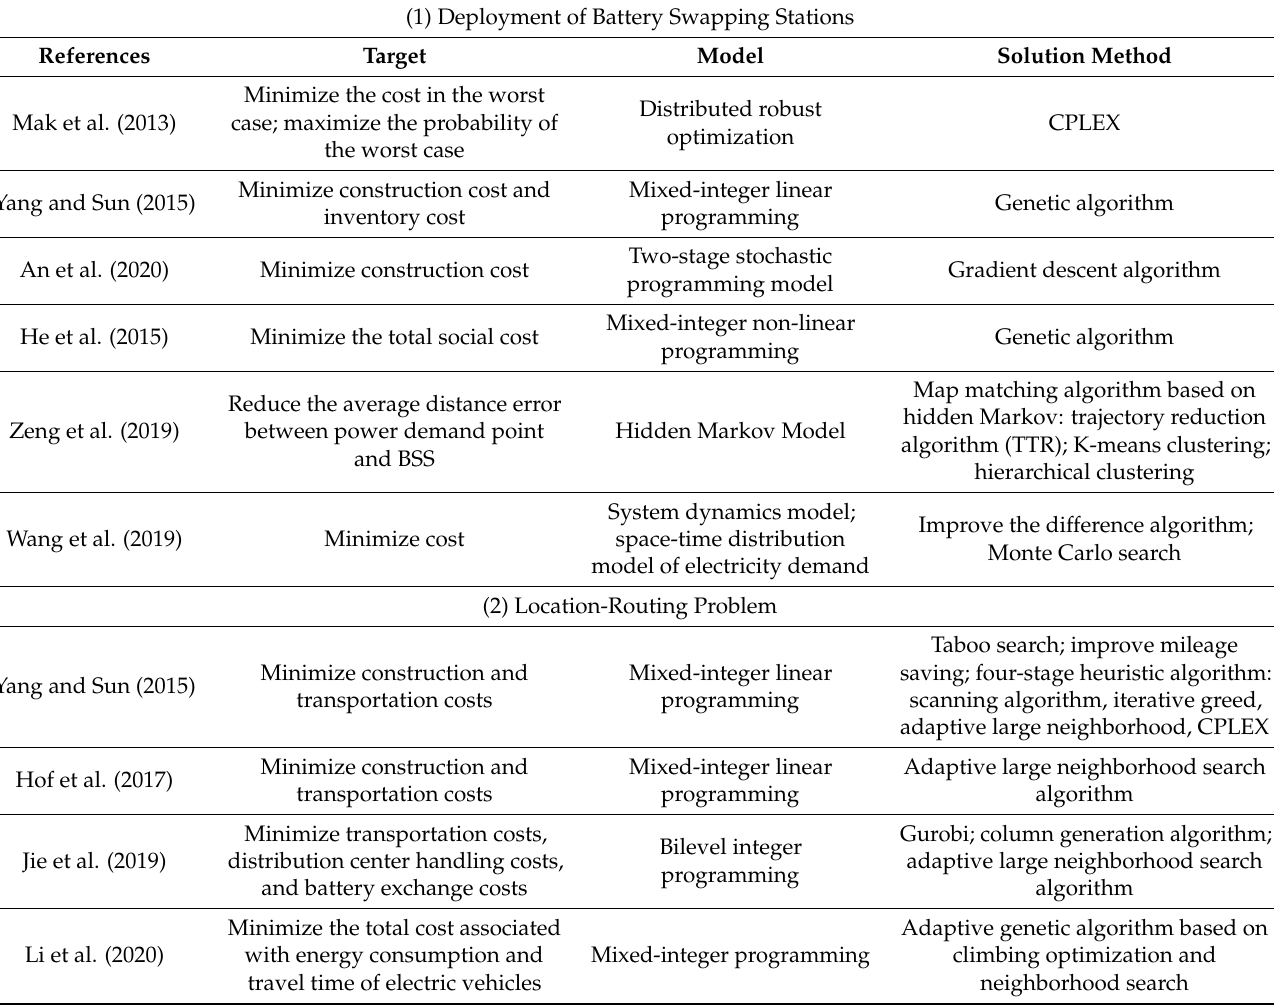
Table 3. Collation of key documents of BSS